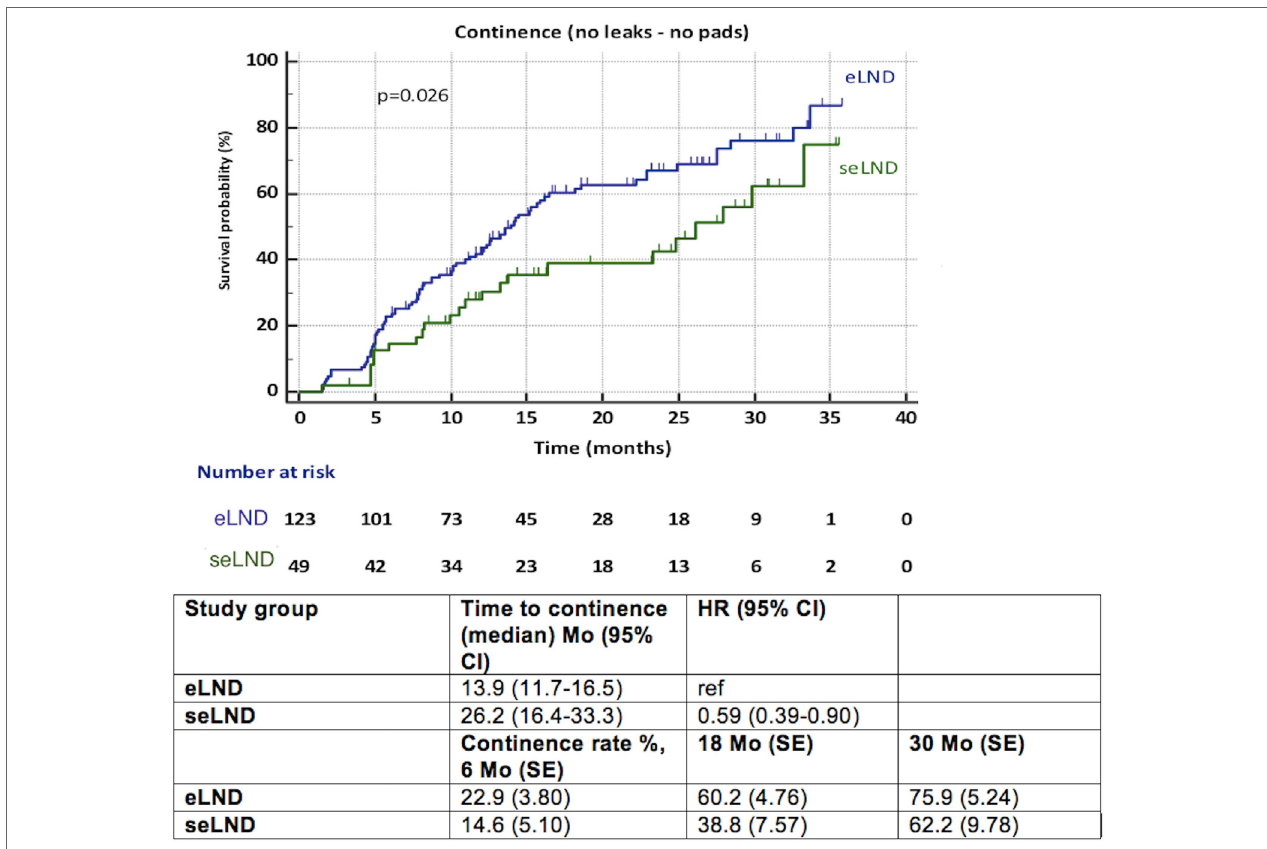
FigUre 2 | Recovery of urinary continence after radical prostatectomy among patients with extended lymph node dissection (eLND) versus super-extended lymph dissection (seLND) during surgery. HR, hazard ratio, Mo, months, CI, confidence interval, ref, reference, SE, standard error.